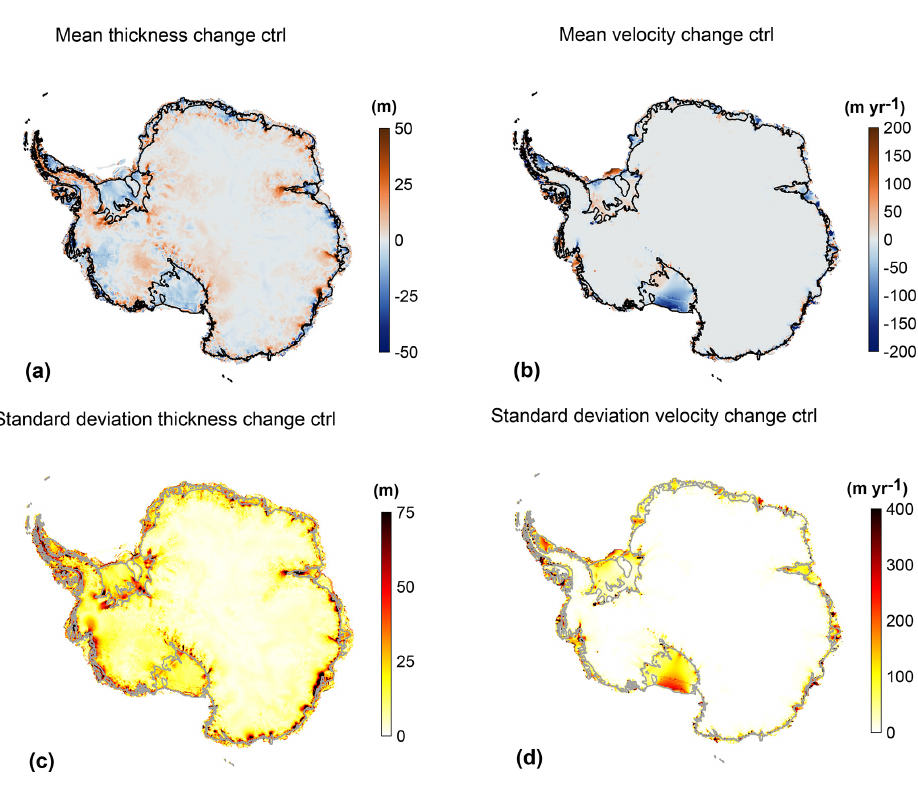
Figure 5. Mean (a, b) and standard deviation (c, d) of the change in ice thickness ( a and c , in m) and depth-averaged horizontal velocity ( b and d , in myr − 1 ) between the beginning and end of the ctrl experiment. Black (a, c) or grey (b, d) lines show the observed current ice front and grounding line positions.